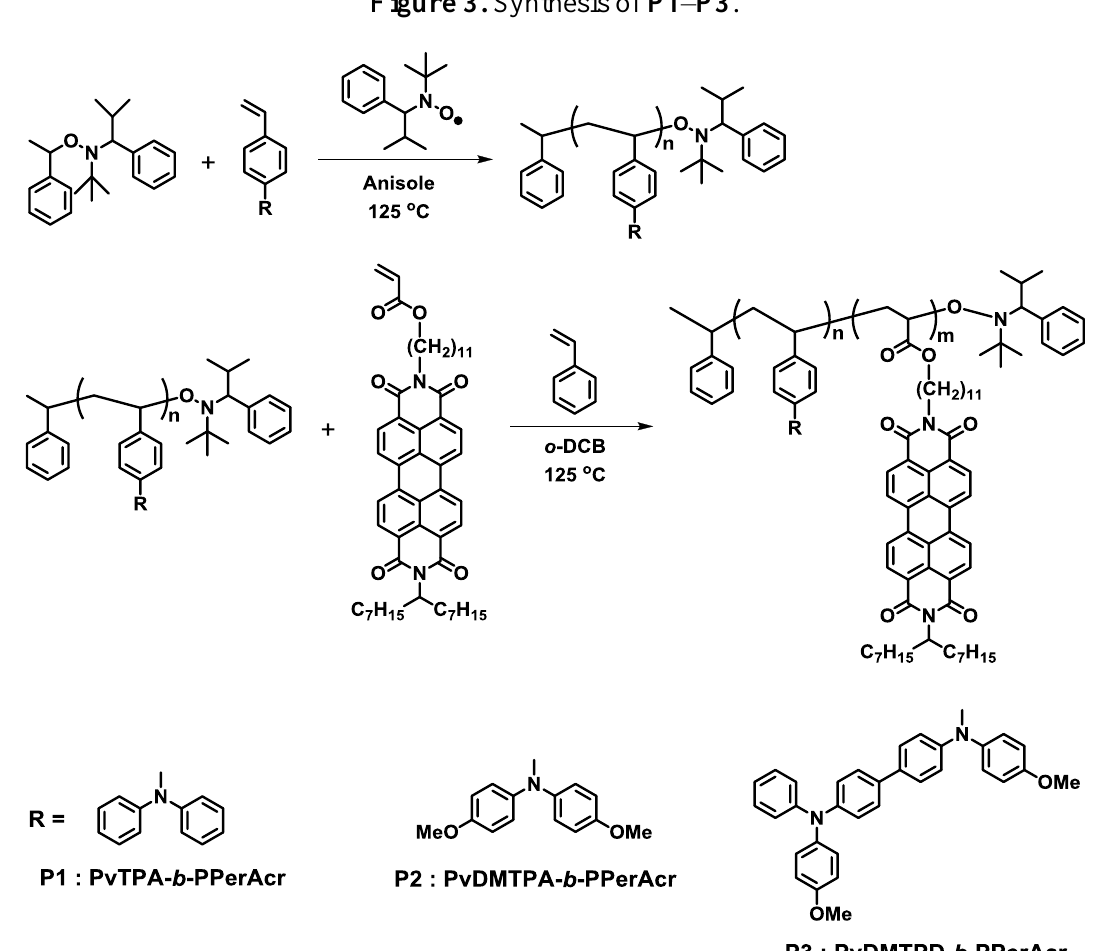
Figure 3. Synthesis of P1 – P3